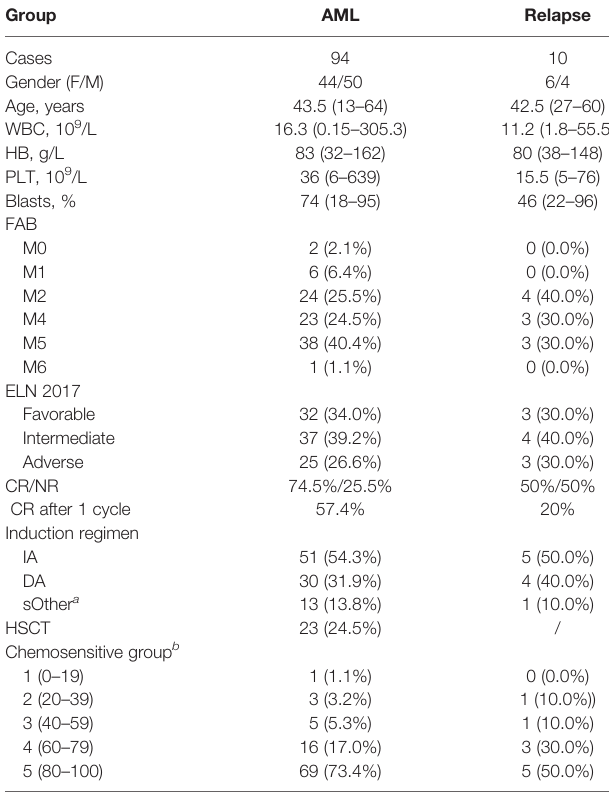
TABLE 1 | General characteristics of 104 AML